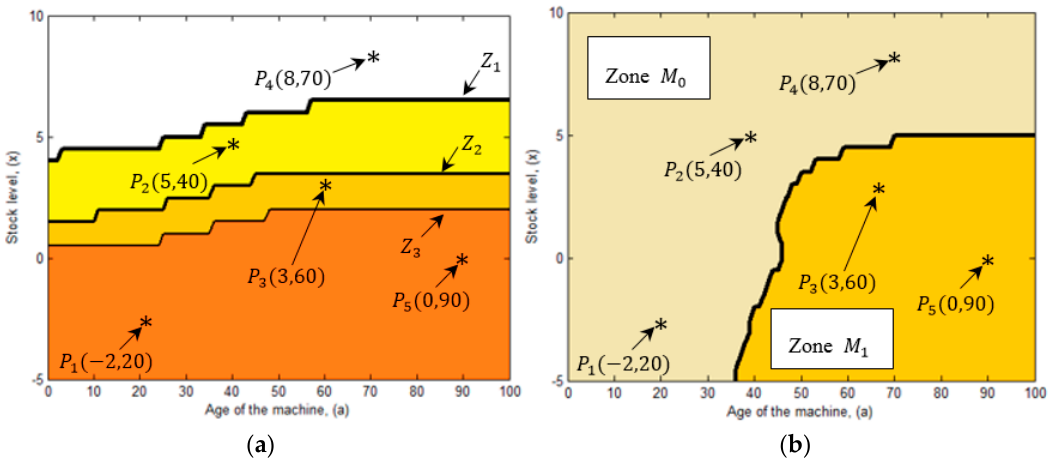
Figure 17. Implementation chart. ( a ) Trace of the production policy; ( b ) Trace of the repair/major maintenance policy.